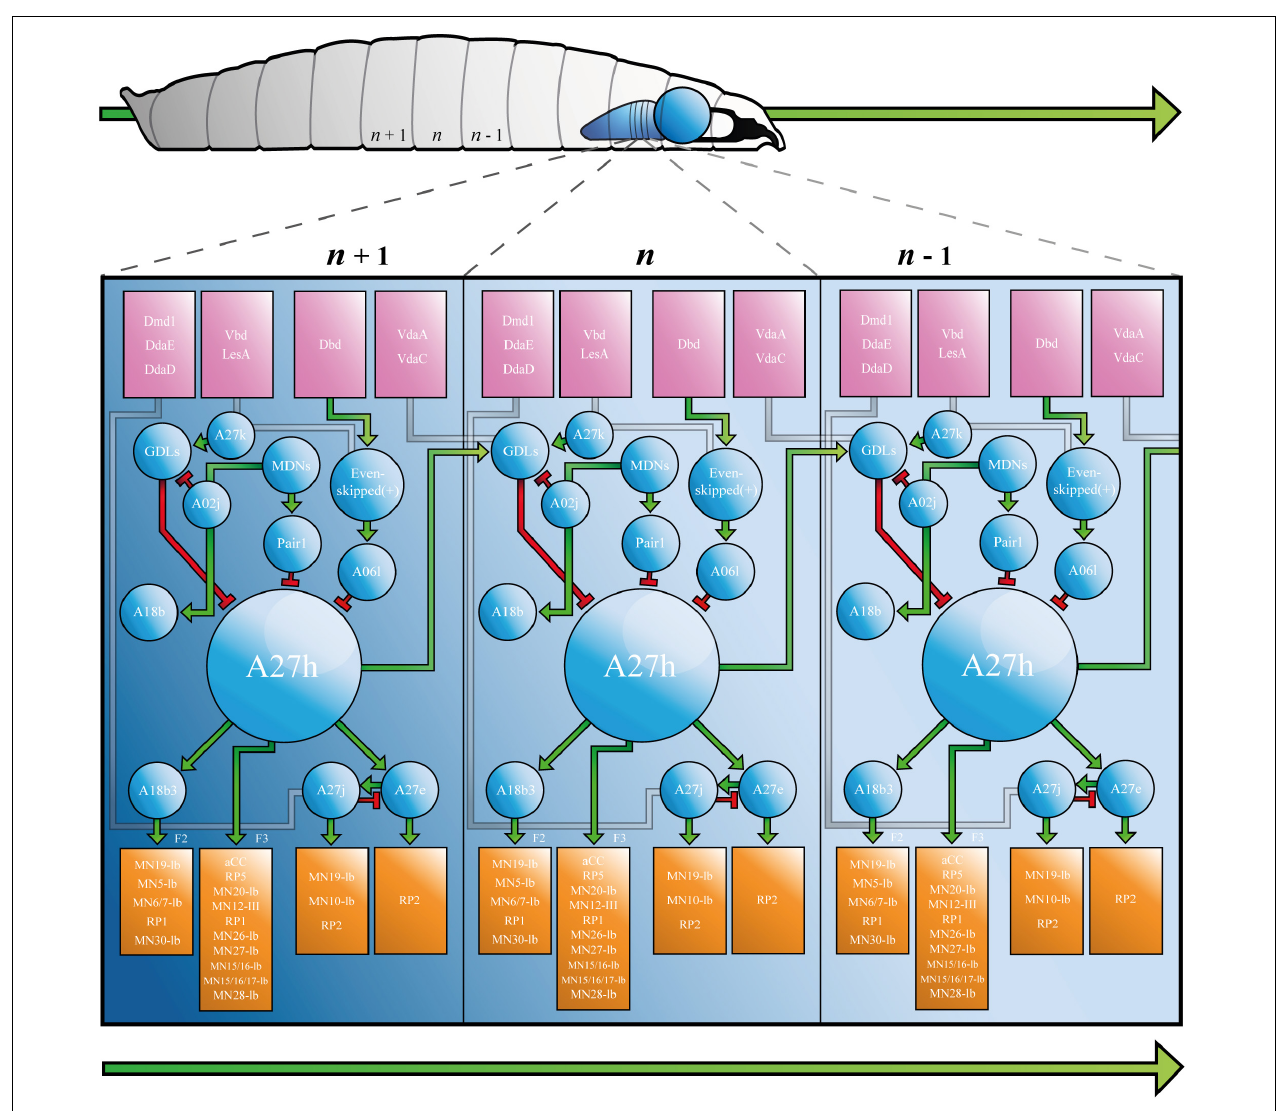
FIGURE 2 | The Drosophila Larva A27h-related Locomotor Circuit. A, Drosophila larva showing ventral nerve cord (VNC) and brain lobe(s), with three segments labelled from most posterior (left, n - 1) to most anterior ( n + 1, right). B, connectivity diagram of the neurons of the larval locomotor circuit. Sensory neurons appear in pink boxes, interneurons in blue circles and motor neurons in orange boxes. Small green arrows represent excitatory synapses, red T-bars represent inhibitory synapses, and grey paths show synapses that have not been completely characterised. F2 and F3 refer to muscle groups discussed in the text. Large green arrows shown in both A and B represent direction of travel, to illustrate that waves of neural activity move from posterior to anterior segments, as the larva crawls forward. See Supplementary Animation 1 for an animated version of this